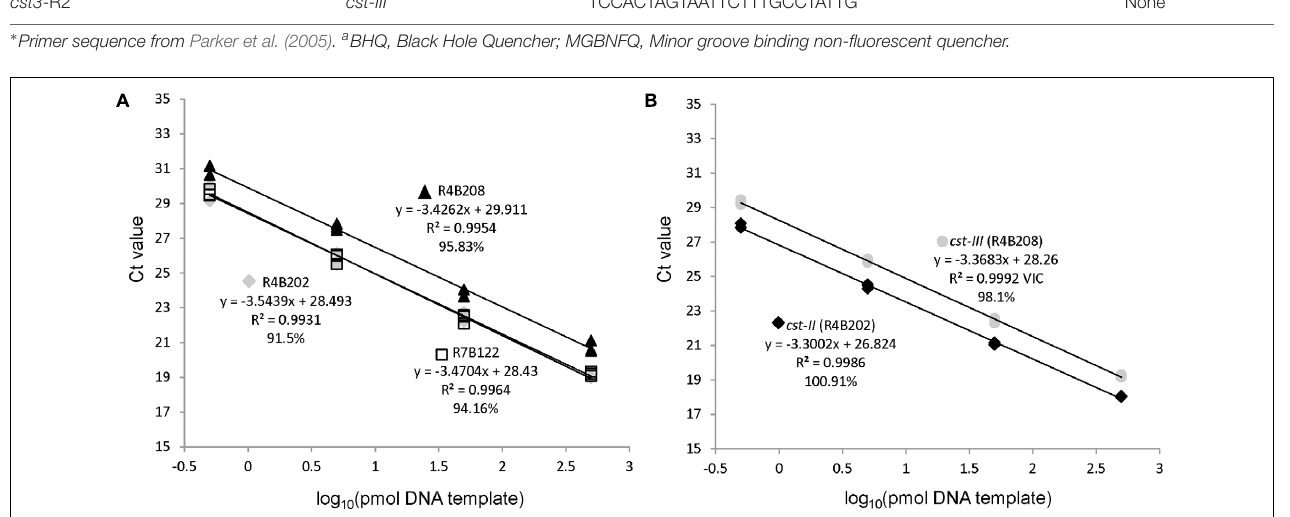
FIGURE 2 | The qPCR assay efficiently amplifies cst-II , cst-III, and waaM . Serial 10-fold dilutions of control strains R4B202 ( cst-II ), R4B208 ( cst-III ), and R7B122 ( cst- negative) were used as template in the multiplex qPCR assay to determine the PCR efficiency of the waaM (A) and cst-II/cst-III (B)